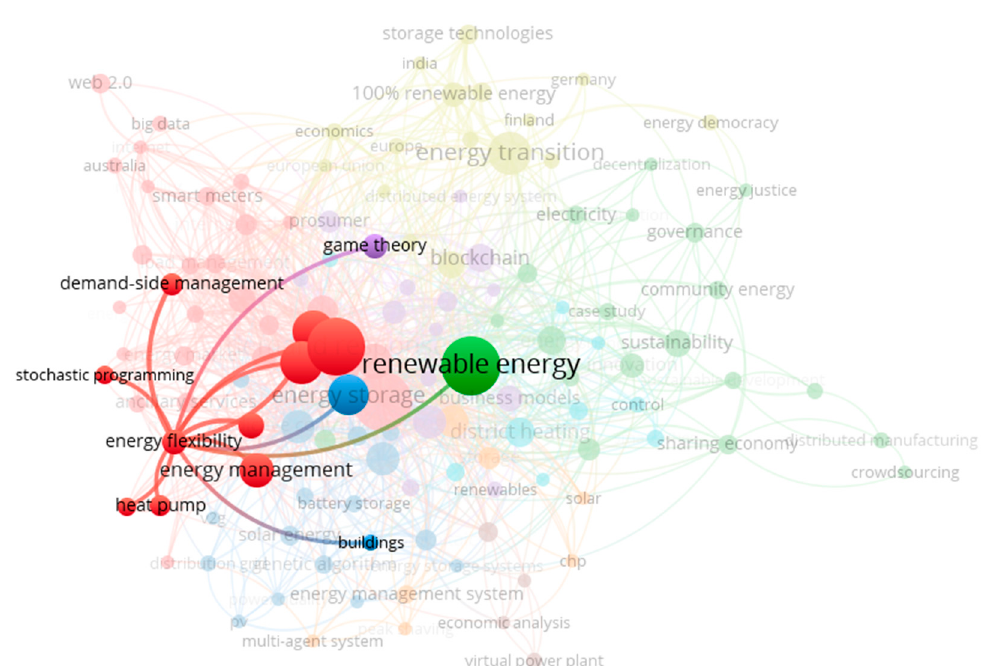
Figure 8. Connections from the term ‘flexibility’.